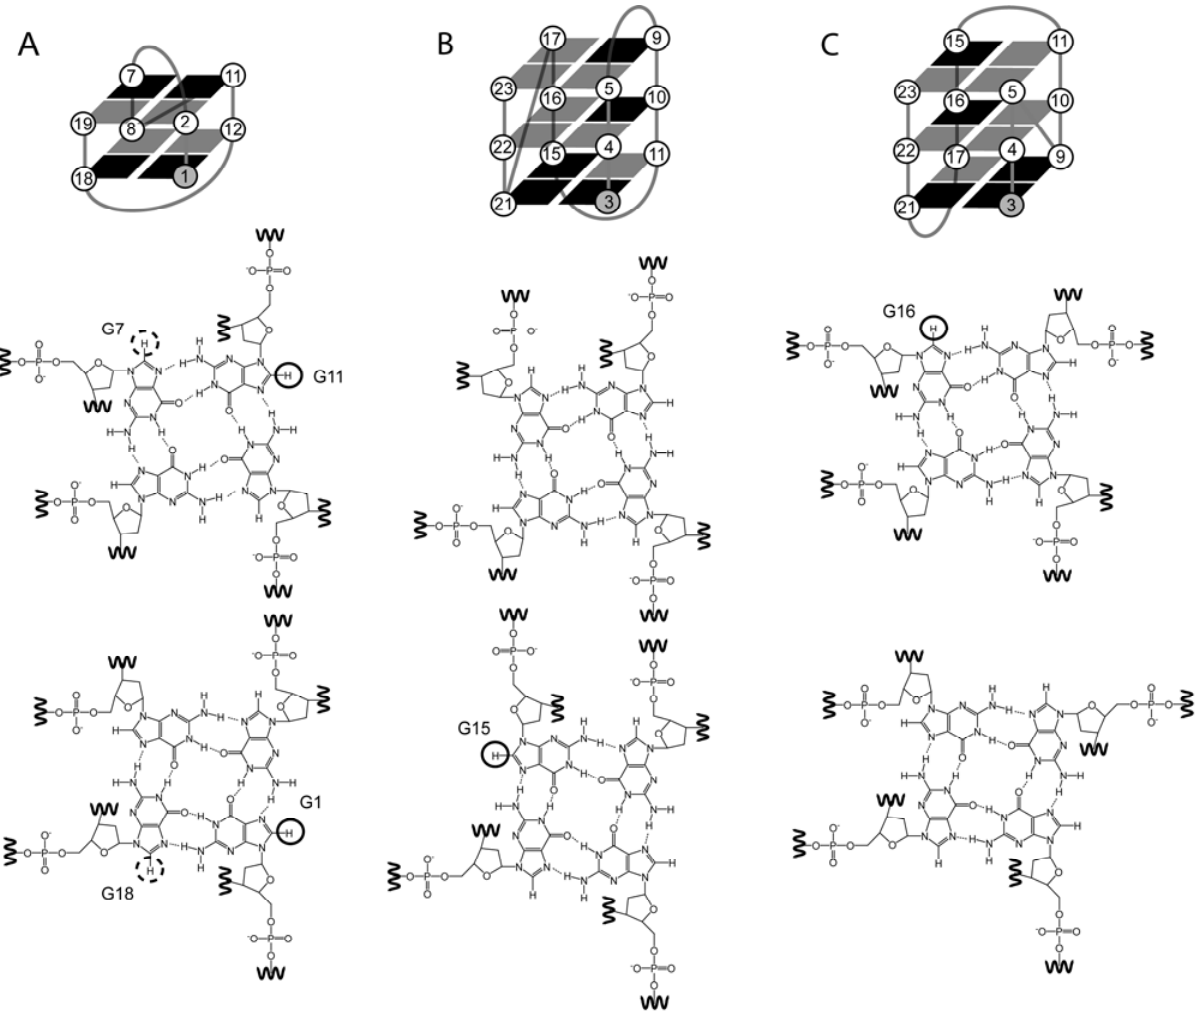
Figure 3. Schematic quadruplex topologies and their corresponding glycosidic bond angle combinations for tetrads is depicted below. The darker shaded areas in the topologies depict guanosines with syn glycosidic bond angle, and the lighter guanosines with anti glycosidic bond angle. The bases highlighted in the chemical structures depict the groove width combinations (medium, narrow, and wide) for the stacked tetrads indicate 8Br- Guanine C8 substitutions studied. The lower tetrad depicted corresponds to the 5'-end tetrad. In ( A ) the (d+pd) loop progression, in ( B ) the (-l-l-p) loop progression; and ( C ) the (-p-l-l) loop